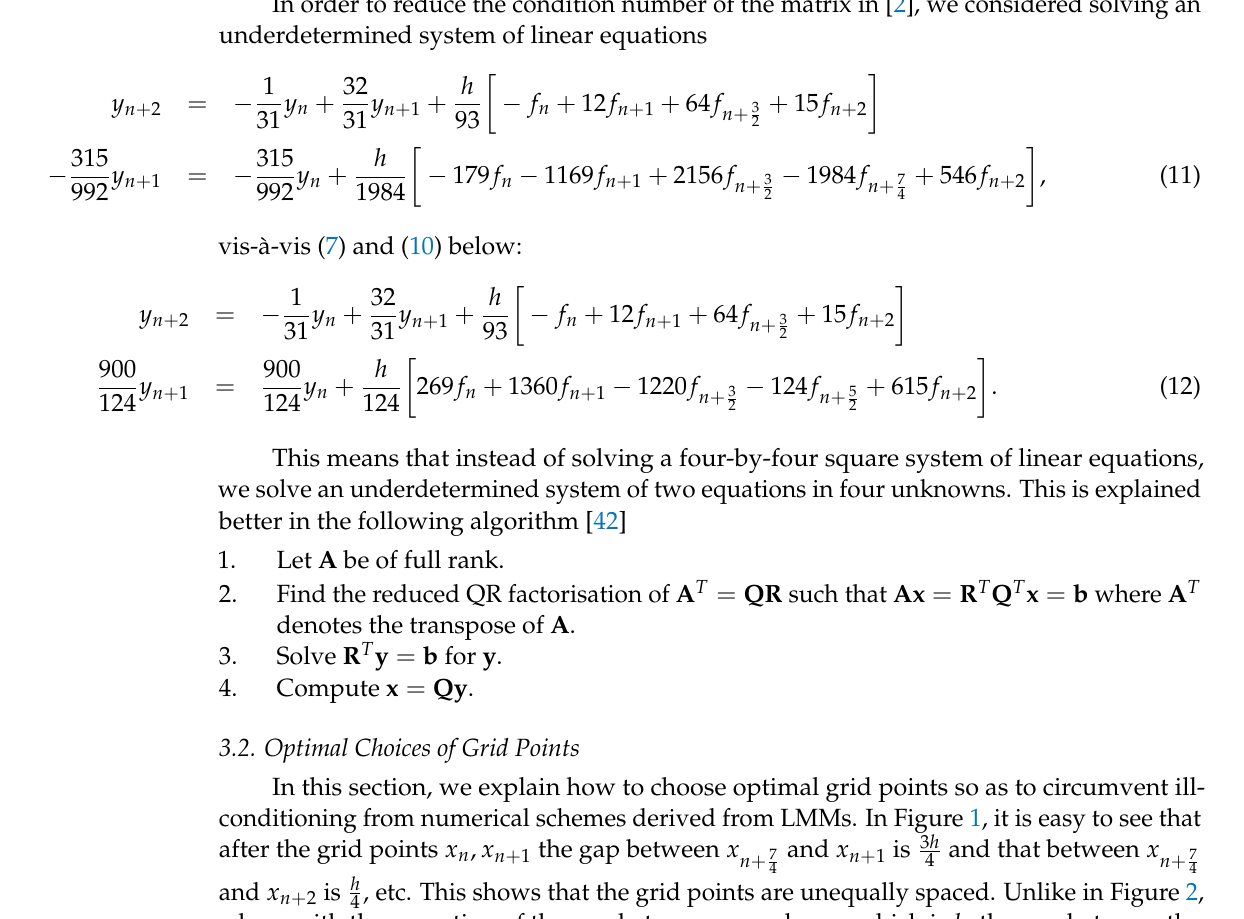
Figure 2. Optimal choices of grid points. and makes D nearly singular. Furthermore, as shown in Table 3 the choices h = 0.2 and 111 h = 0.5 implies D matrix is non-singular. 112 Table 1. Choice of step sizes h . det D =